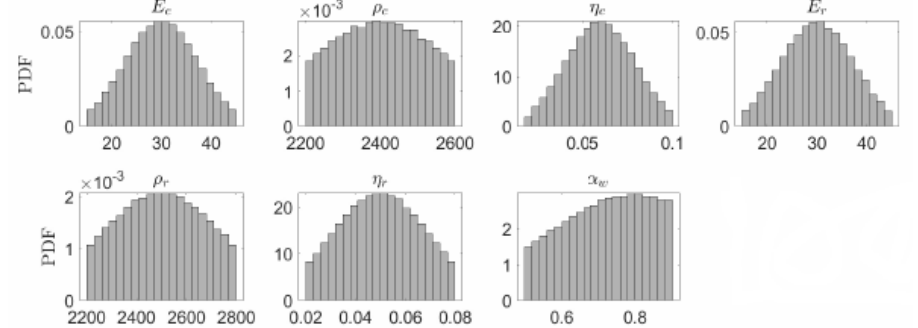
Figure 4. Distribution of material